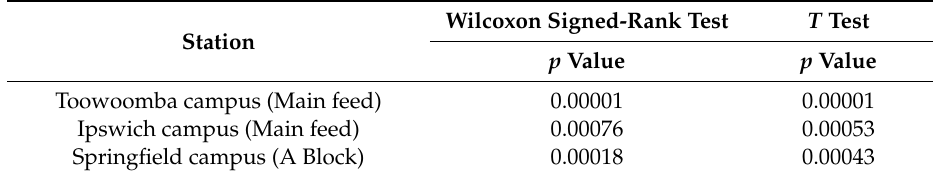
Table 4. Wilcoxon Signed-Rank test and T test results for the | FE | of the MOPE model vs. the | FE | for the POE